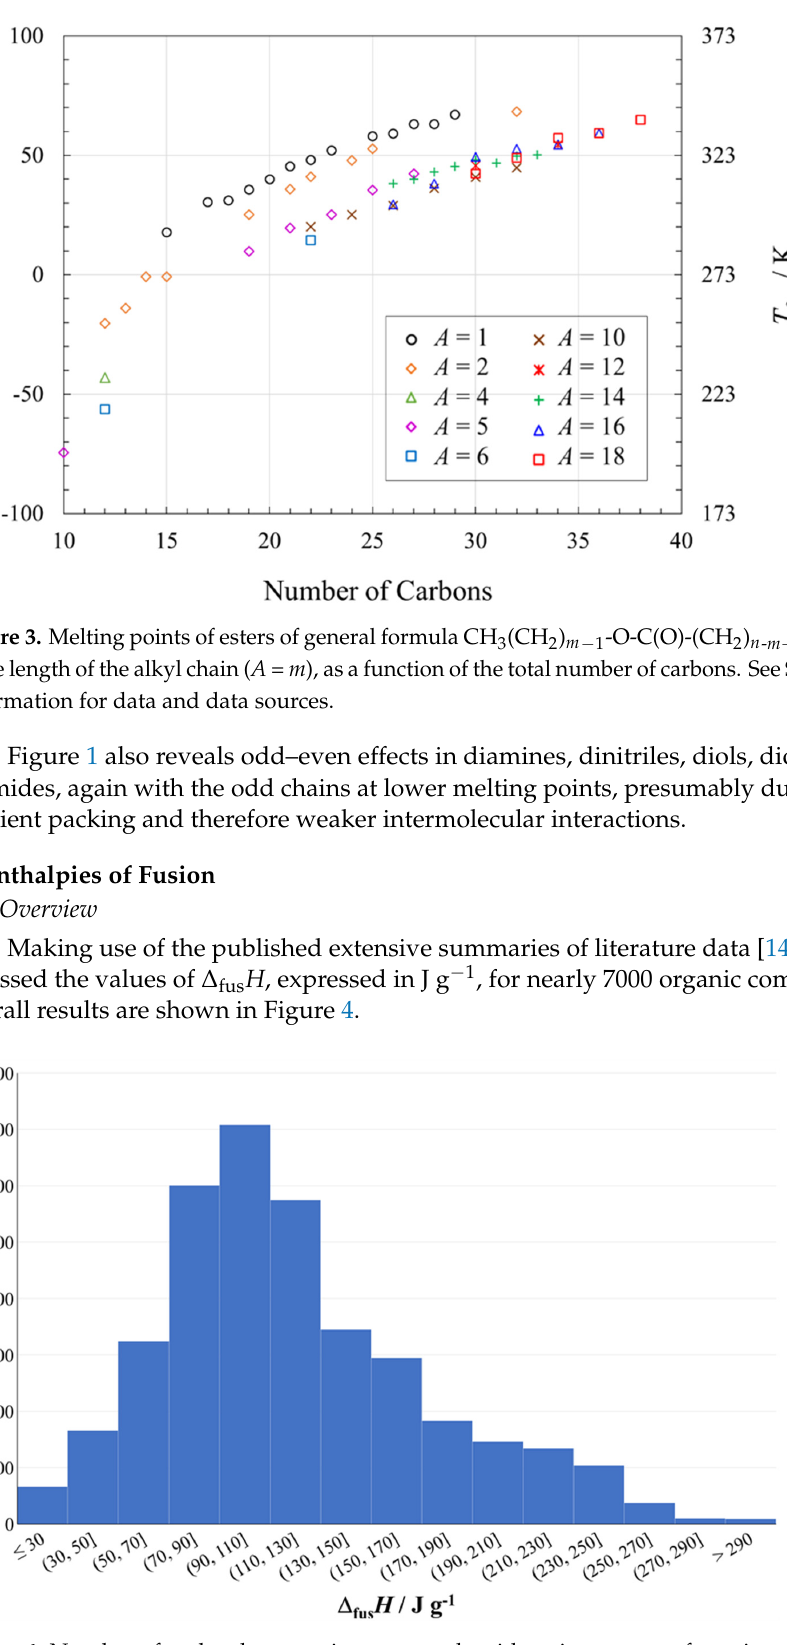
Figure 4. Number of molecular organic compounds with a given range of gravimetric enthalpy of fusion, Δ fus H expressed in J g − 1 , based on published summaries of literature data [14,15]. Most of these ~7000 organic compounds, the families of which extend far beyond the nine considered in detail here, have Δ fus H values of ~100 J g − 1 . This range would be suitable for use as phase change materials and provides an energy density of ca. 30 Wh kg − 1 which is comparable to some batteries, but higher values of Δ fus H are better. Note again that Δ fus H for water is 334 J g − 1 , which is exceptionally high due to H 2 O’s relatively high melting point (273 K; despite the lower molar mass, the H 2 O melting point is higher than H 2 S [187 K] and H 2 Se [208 K] due to strong hydrogen bonding in H 2 O). Therefore, H 2 O offers a unique opportunity for use as a PCM near 273 K. Nevertheless, based on Figure 4, there are a number of organic compounds with Δ fus H values of >200 J g − 1 . Detailed consideration of the compounds in this category again reveals the importance of flexibility of the mole- cules and the importance of hydrogen bonding. Further detailed analysis here is confined to the nine families of compounds described above, which exemplify these features. 3.2. Alkanes Alkanes (paraffins) are among the most prominent PCMs used commercially, in ap- plications including residential solar thermal systems and passive thermal management systems. From Figure 5, it is apparent that the values of Δ fus H are favorable for thermal energy storage (>100 J g − 1 ) and that the odd–even chain length effect observed in the alkane melting points (Figure 2) is even more prominent in Δ fus H .